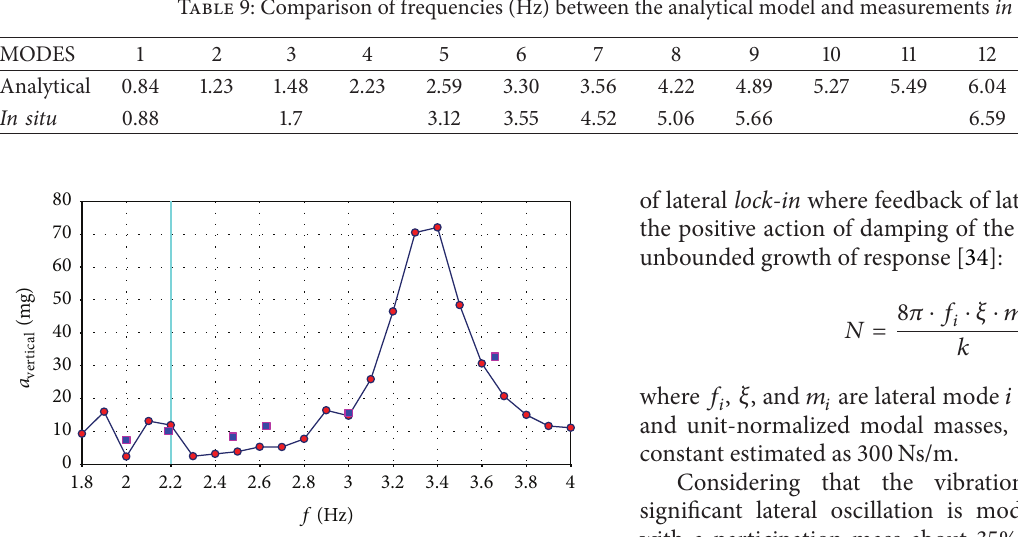
Figure 14: Comparison of amplitudes at mid-span (vertical accel- eration) between in situ measurements and the analytical model: one person walking at various speeds (RC structure). Red circles: analytical model; blue squares: in situ measurements; vertical line at 2.2 Hz separates “walk” from “running.” Table 10: Acceleration measured at 1/2 span for the normal walking.